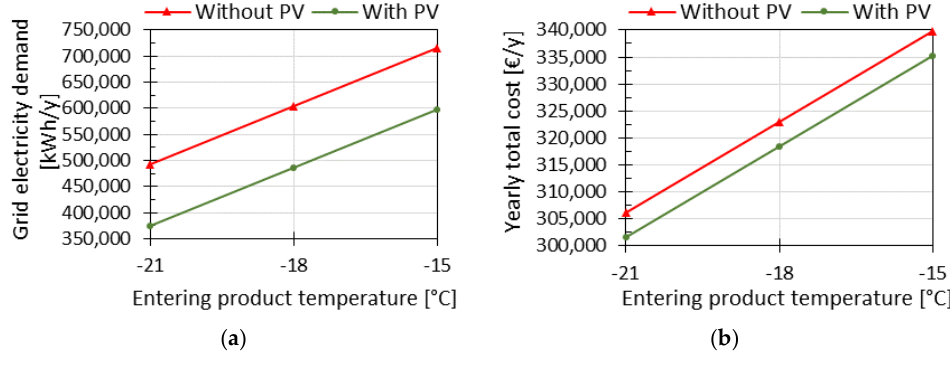
Figure 11. Sensitivity analysis on product temperature: ( a ) electricity withdrawal from the grid and ( b ) yearly total cost.